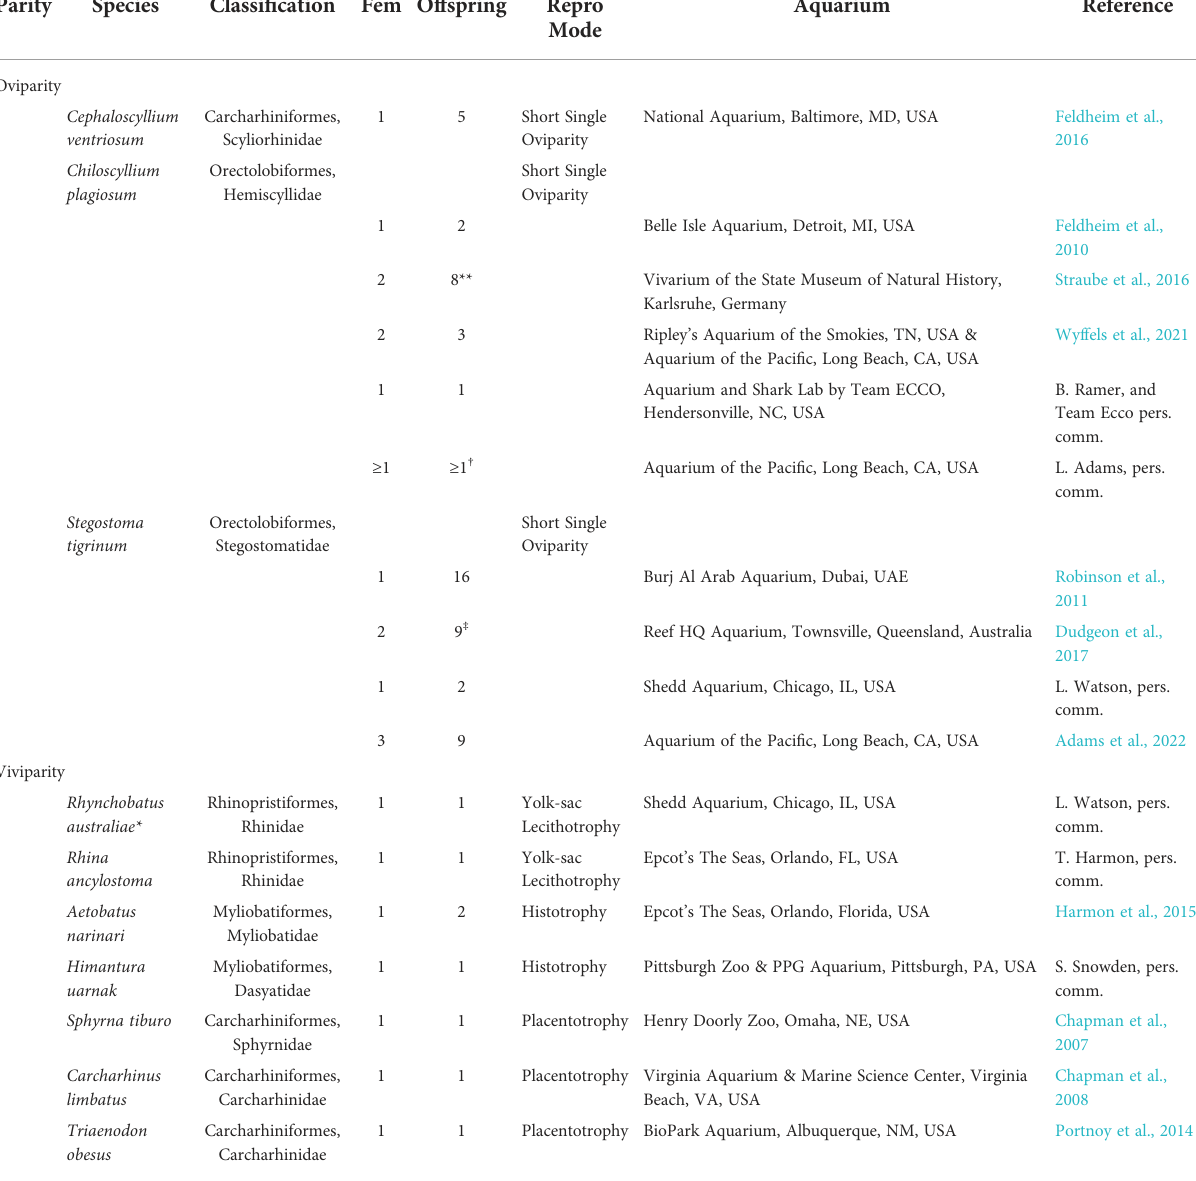
TABLE 1 Cases of parthenogenesis from aquaria. Fem indicates the number of females in that study that gave birth via parthenogenesis. Offspring represents the number of parthenotes in the study. Repro Mode is the reproductive mode of the species.